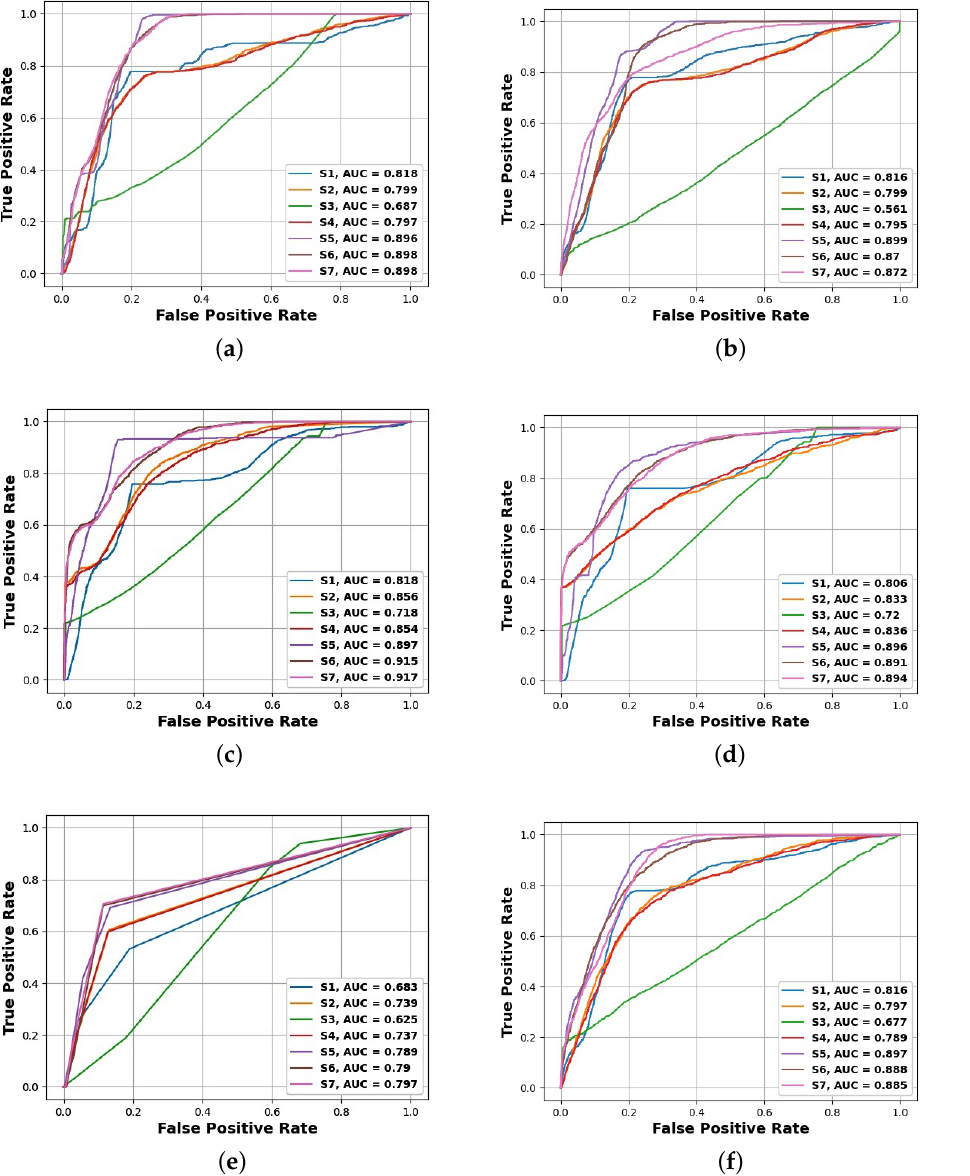
Figure 5. ROC curves for particular algorithms and attribute subsets. ( a ) LR classifier; ( b ) SVC classi- fier; ( c ) RF classifier; ( d ) GB classifier; ( e ) KN classifier; (f) MLP